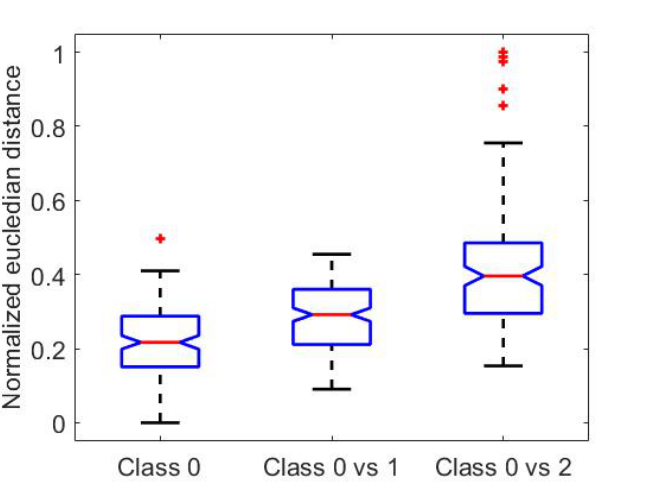
Figure 3. Intra-class distance (Class 0), inter-class distance between classes 0 and 1, inter-class distance between classes 0 and 2. Antero-posterior acceleration